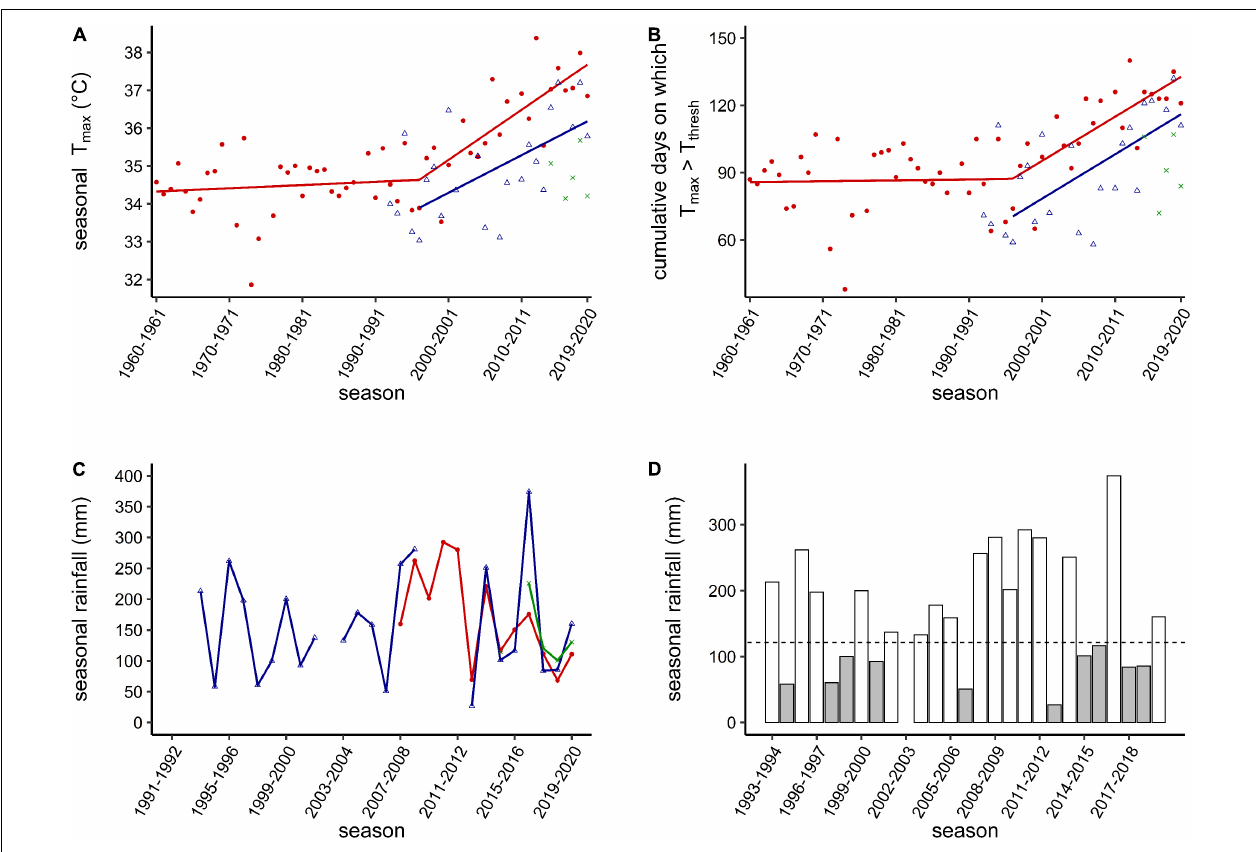
FIGURE 1 | (A) Trends in seasonal T max [mean maximum daily air temperature (T air )], (B) cumulative DaysT thresh [days on which T max > T thresh (T air = 34.5 ◦ C)], and (C) cumulative rainfall for each southern yellow-billed hornbill ( Tockus leucomelas ) breeding season (19 October–24 March each year) modeled from Hot Birds Research Project (HBRP; the on-site weather station, green crosses), Twee Rivieren (red circles, ∼ 120 km from the study site), and Van Zylsrus (blue triangles, ∼ 30 km from the study site) weather station data. A significant increase in T max ( ± 3.5 SE years) and cumulative DaysT thresh ( ± 4.1 SE years) starting in approximately 1996–1997 was identified using segmented analysis for the TR weather station. (D) Bar plot for cumulative rainfall from the VZ weather station (data from TR between 2009 and 2012 included where VZ rainfall data were unavailable) with a dotted line showing the threshold for drought (gray bars) vs. non-drought (clear bars)